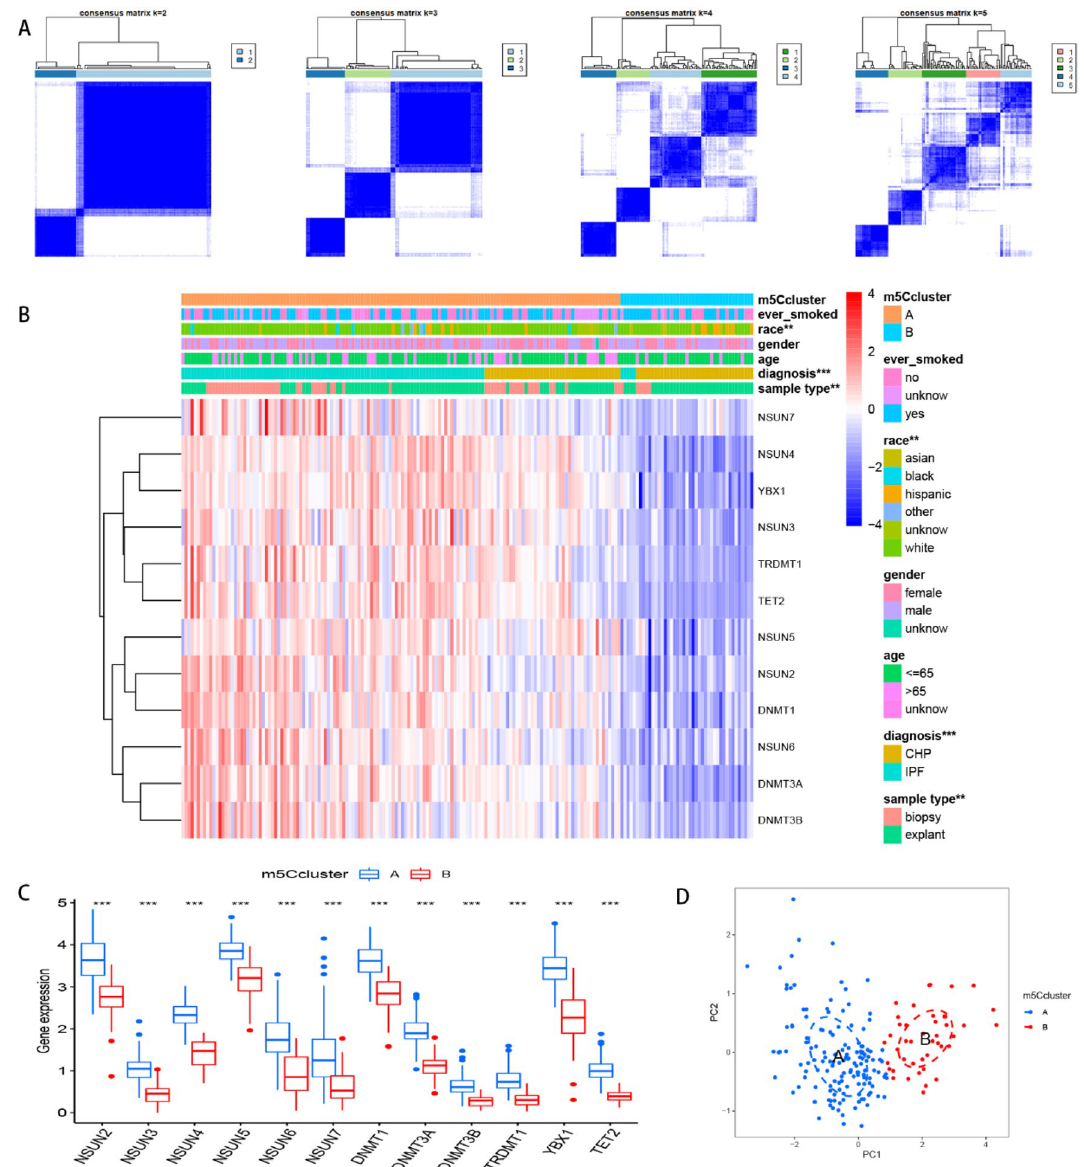
Figure 5. Consensus clustering of m5C regulators. ( A ) Consensus matrices of the 12 m5C regulators (k = 2–5). ( B ) Expression of 12 significant m5C regulators in the heatmap. ( C ) Expression of 12 significant m5C regulators in the boxplot. ( D ) PCA showed the striking difference in modification cluster A (the blue pattern) and cluster B (the red pattern). * p < 0.05, ** p < 0.01, and *** p <